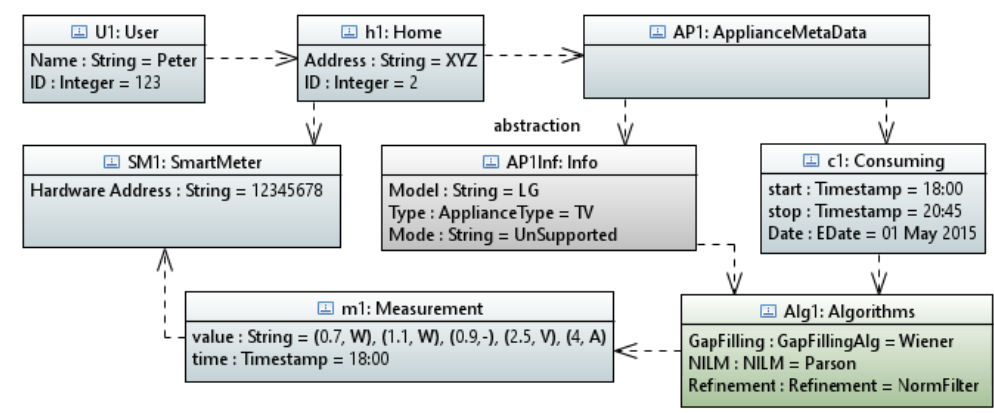
Figure 14. UML object diagram of a home.